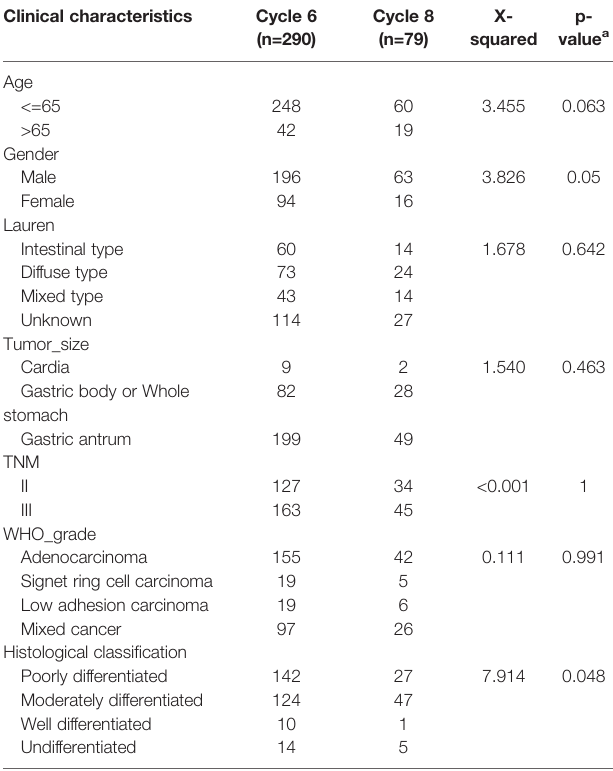
TABLE 1 | Clinical characteristics of patients with gastric cancer after D2 resection enrolled in this study. Clinical